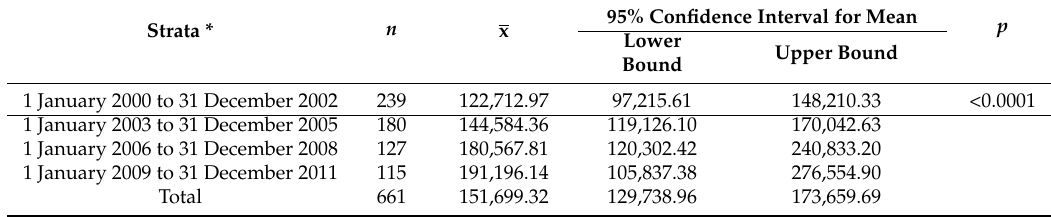
Table 2. Viral load mean value across time in subjects with detectable viral load only, Puerto Rico,